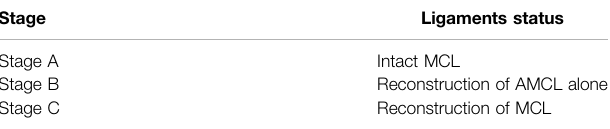
TABLE 1 | Stages of medial collateral ligament reconstruction.